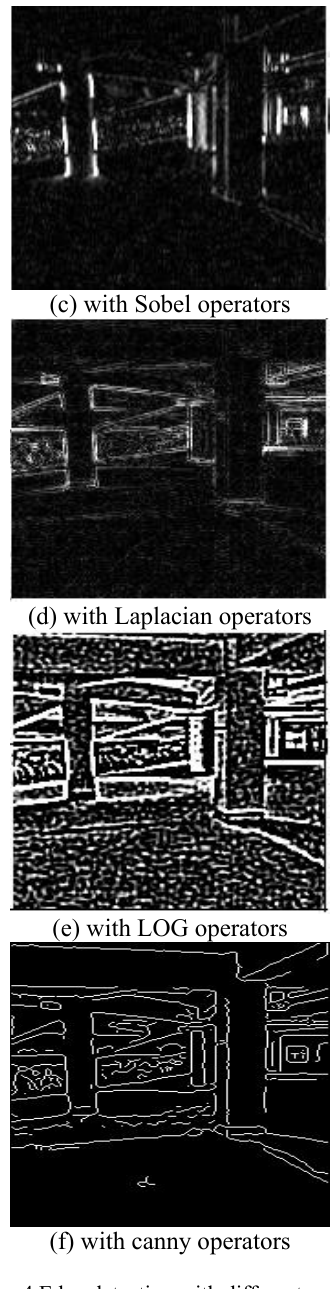
Figure 4 Edge detection with different